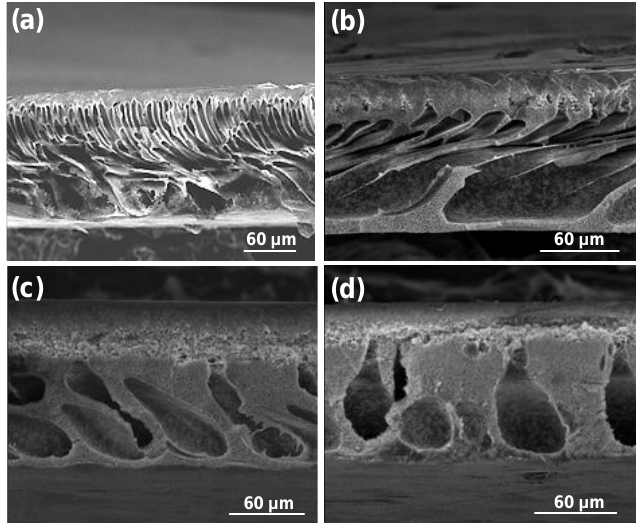
Figure 4. Membrane top layer thickness versus nonsolvent ratio for three different solvent ratios.